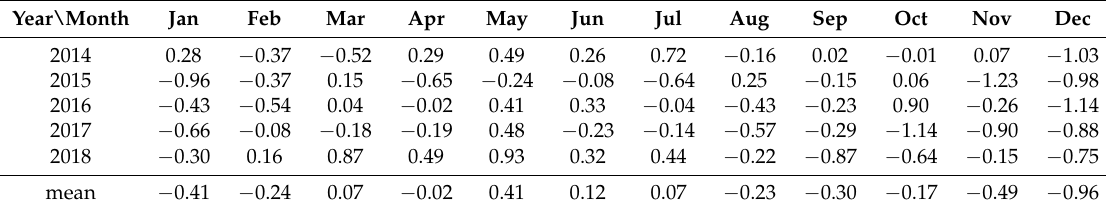
Table A9. Monthly means for sea surface height for the years 2014–2018.